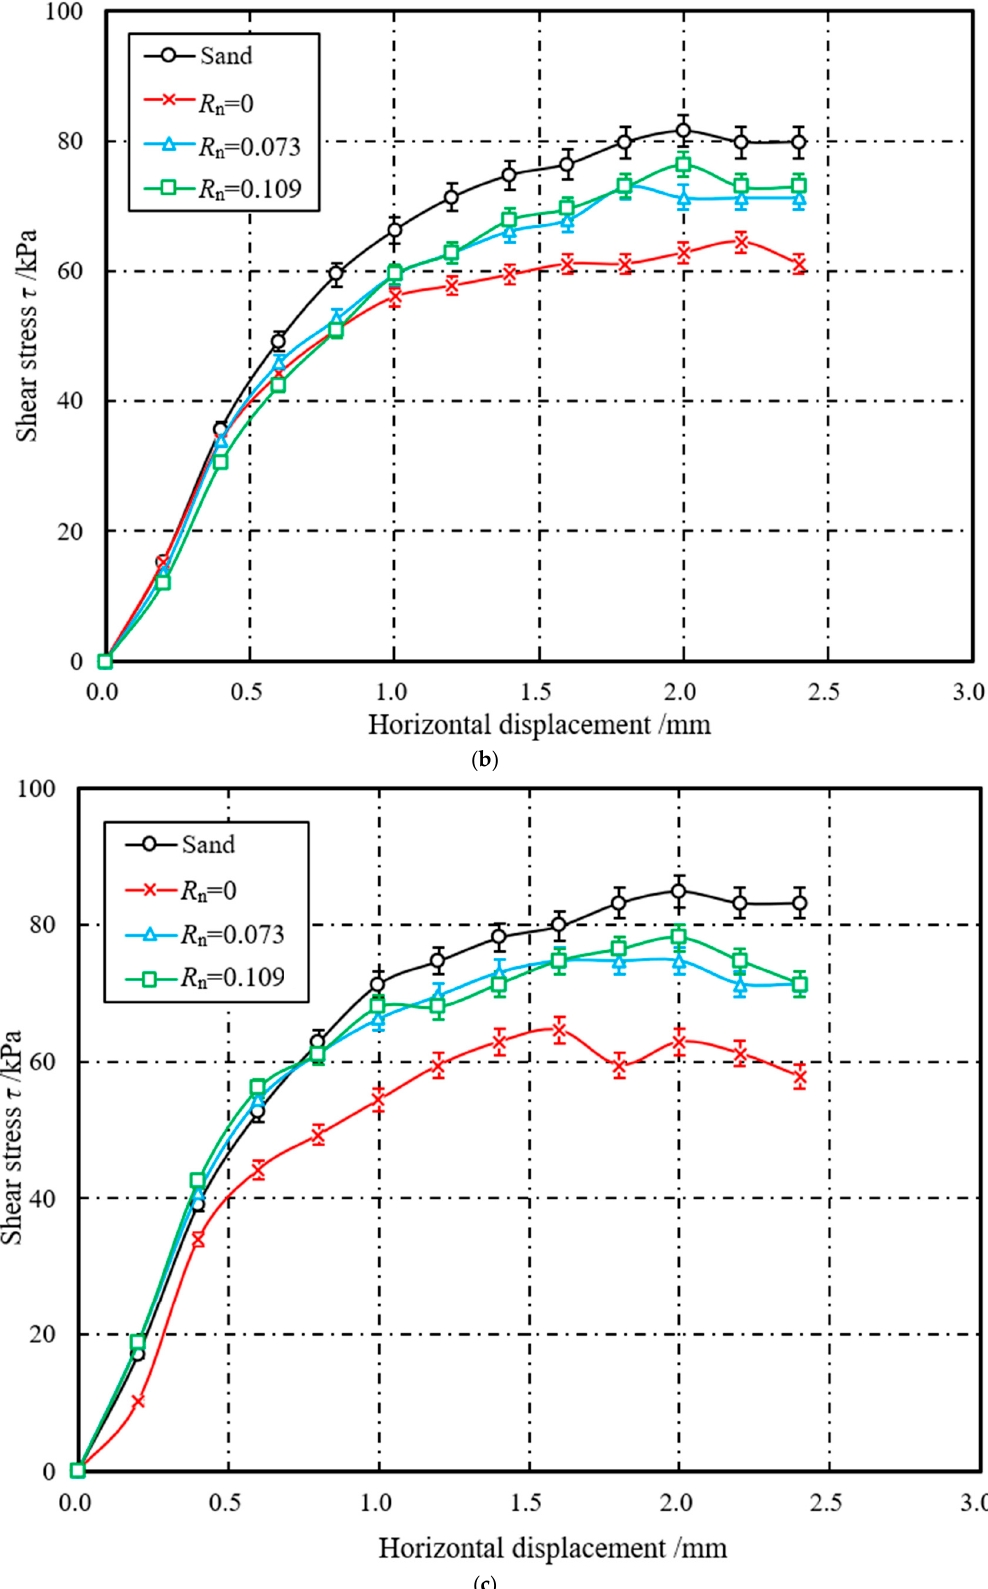
Figure 6. Shear stress–horizontal displacement curves for 100 kPa normal load: ( a ) 0.63–1.25 mm sand; ( b ) 1.25–2.50 mm sand; ( c ) 2.50–5.00 mm sand. Note: R n is the relative roughness